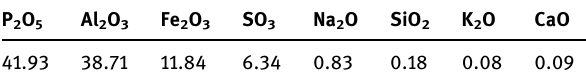
Table 3: Compositon of the iron aluminum - containing phosphates generated ( wt% )